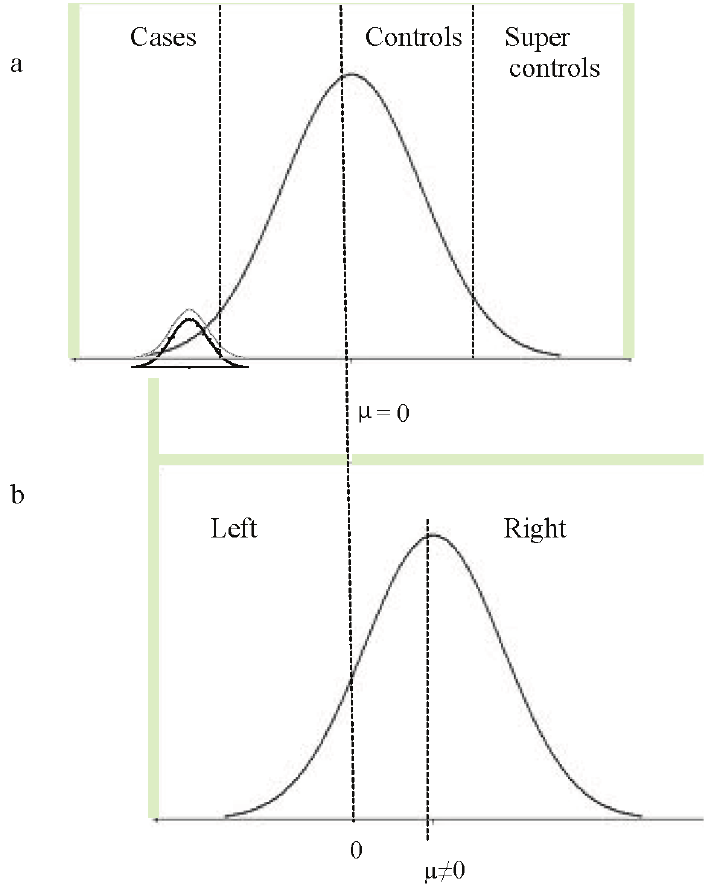
Figure 1. Study design for quantitative phenotypes ( a ) genome-wide association (GWA) studies for speech and language-related traits typically use phenotypes across the entire distribution (population-based quantitative GWA studies). Others might apply a binary affection status under which low language- performing individuals are defined as “cases” and individuals within the “normal” language range (usually performance above the mean) as “controls”. Under certain conditions, “super - controls” can provide more power, as they are selected to fall at the upper extreme of the distribution. If controls with phenotype data are not available, they may be derived from standard control populations under the knowledge that they might include a small proportion of cases. Quantitative GWA studies restricted to cases may be based on a phenotypic distribution restricted to the lower tail of the entire distribution or may be based on a phenotypic curve derived across cases samples, as denoted by the two normal distributions in ( a ) (note that in ( a ), the phenotype distribution may not necessarily be expected to be normal, although it is shown as such in the figure). ( b ) The pegboard test generates a quantitative measure for handedness (PegQ) that is normally distributed around a positive mean. PegQ strongly correlates with hand preference, so that individuals with positive scores are very likely to be right-handed (roughly 90% of the population), and individuals with negative scores are likely to be left handed. Typically genetic studies for handedness have used the categorical measures of hand-preference using a case-control (left vs. right) study